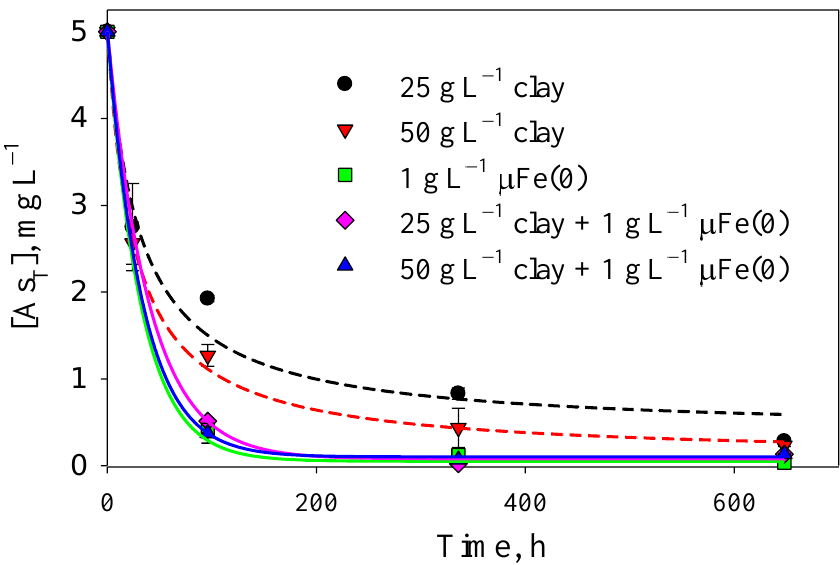
Figure 8. Total arsenic removal ([As T ]) with the clay, µ Fe(0) and the combination of the clay and µ Fe(0) starting from As(III) solutions. Conditions: [As(III)] 0 = 5 mg L − 1 , pH 7, RT, EC = 0.03 mS cm − 1 , no stirring. Error bars represent the standard deviation between duplicates, while the full lines are the adjustment to a pseudo-first-order kinetics with Equation (3), and the dashed lines are the fittings to Equation (6), with [As T ] values calculated from q using Equation